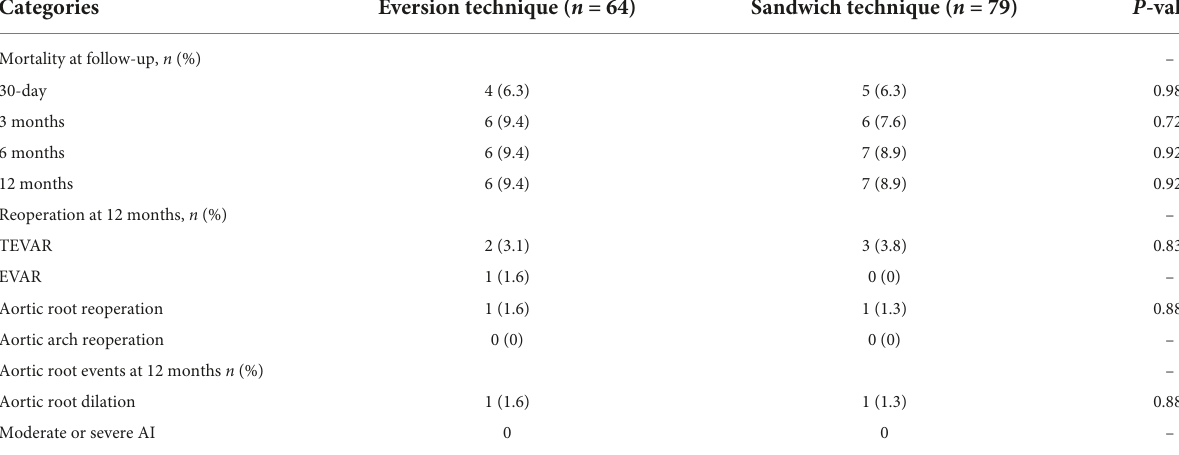
TABLE 4 One-year follow-up